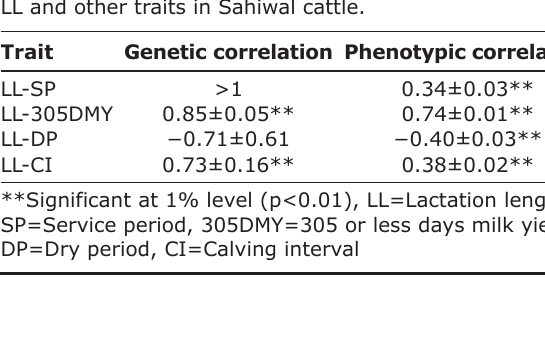
Table-2: Descriptive statistics of LL having class interval of 50 days. Class range (LL in days)